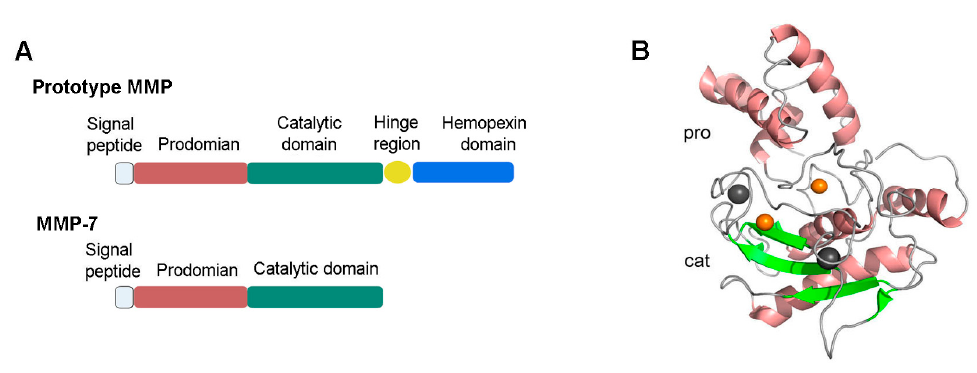
Figure 1. Structure of proMMP-7. ( A ) Full-length proMMP7 only consists of two domains: a pro-peptide domain (pro) and a catalytic domain (cat), which separates it from the prototype of MMPs. ( B ) The pro-peptide domain consists of three α -chains and connecting loops. The catalytic domain contains two zinc ions, two copper ions, and a ball-like structure consisting of three α -helices, five β -sheets, and multiple loops [16]. The image was prepared from Protein Data bank entries 2MZE (proMMP-7) using the PyMol (http: // www.pymol.org). MMP, matrix metalloproteinase. MMP-7 protein is produced and secreted as an inactive zymogen, which is maintained by a conserved cysteine residue that interacts with the zinc in the active site, rendering the protease inactive [16]. Disruption of this so-called cysteine switch is required for activation and can occur via